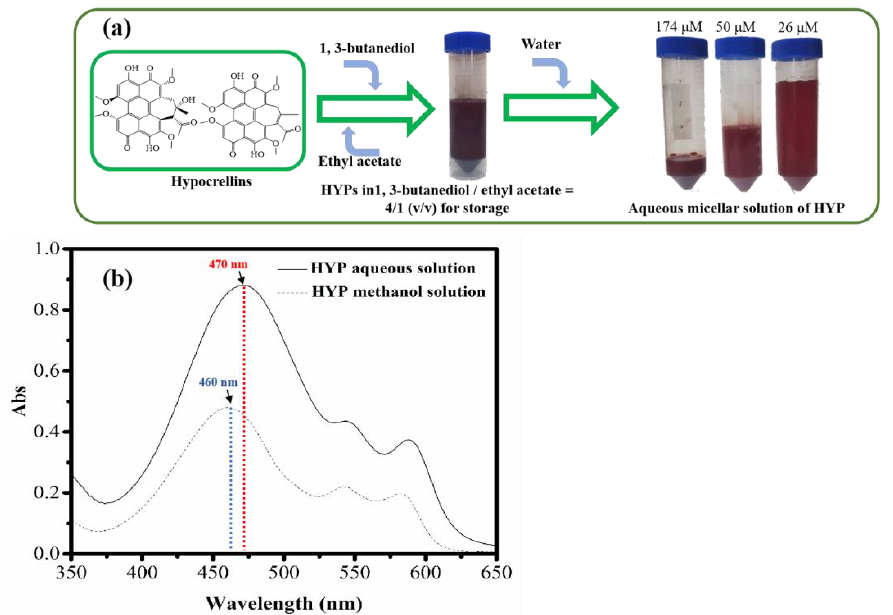
Figure 3. Procedure for the preparation of ( a ) aqueous micellar solution of HYPs and ( b ) absorption spectra of the HYP aqueous solution and HYPs methanol solution.